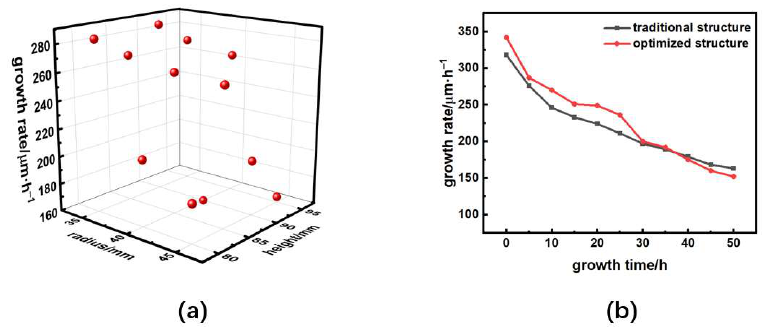
Figure 7. Crystal growth rate with different graphite block sizes: ( a ) average growth rate with different graphite block sizes and ( b ) growth rate at different time in different structure.